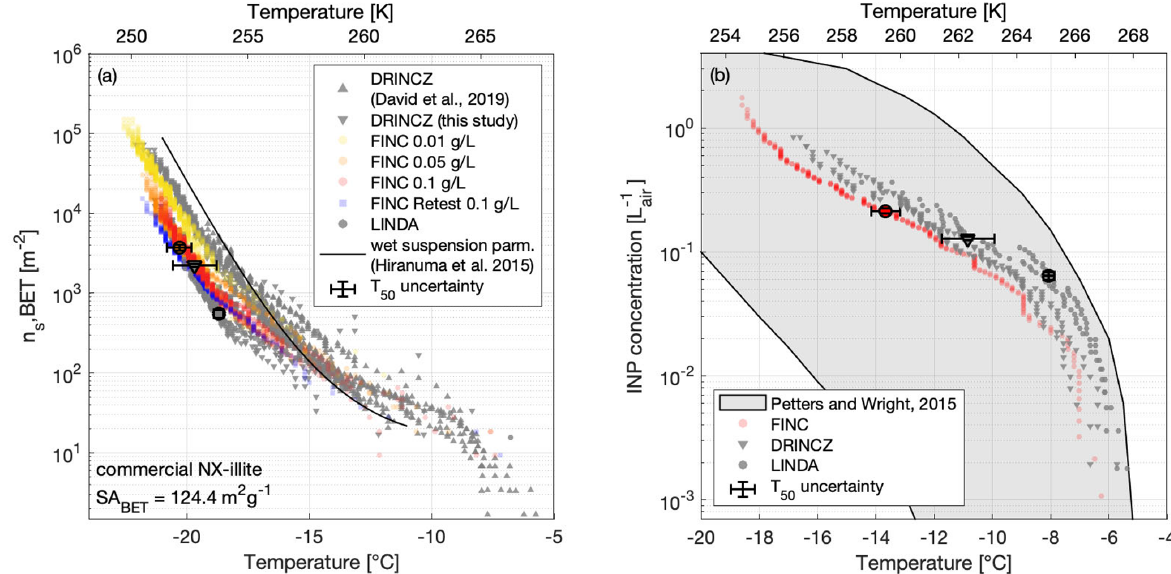
Figure 4. (a) The active surface-site density n s,BET of NX-illite suspensions measured on FINC (yellow, orange, red dots), DRINCZ (grey downward triangles), and LINDA (grey dots) during the intercomparison. The wet suspension parameterization by Hiranuma et al. (2015a) is plotted for reference. Concentrations used were 0.1, 0.05, and 0.01gL − 1 of NX-illite. The DRINCZ illite measurements as reported in David et al. (2019) are also shown for comparison (grey upwards triangles). n s,BET was calculated using a BET surface area of 124.4m 2 g − 1 (Hiranuma et al., 2015a). Error bars in the x and y direction are shown on the T 50 value for one sample each from DRINCZ, LINDA, and FINC (see Supplement Sect. S11 for details). Note that the y -direction uncertainties do not extend beyond the marker. (b) INP concentrations (L − 1 ) of an ambient aerosol sample solution from Zurich, Switzerland, measured on FINC (red dots), DRINCZ (grey triangles), and LINDA air (grey dots). Ambient aerosols were collected with a Coriolis µ impinger for 20min at 300Lmin − 1 . The sample was split for measurements on each of the immersion freezing instruments. One measurement run was done with FINC; two runs each were done with DRINCZ and LINDA. The grey shaded area denotes the range of INP concentrations from precipitation and cloud water samples compiled by Petters and Wright (2015). Error bars in the x and y direction are shown on the T 50 value for one sample each from DRINCZ, LINDA, and FINC (see Supplement Sect. S11 for details). Note that the y -direction uncertainties do not extend beyond the